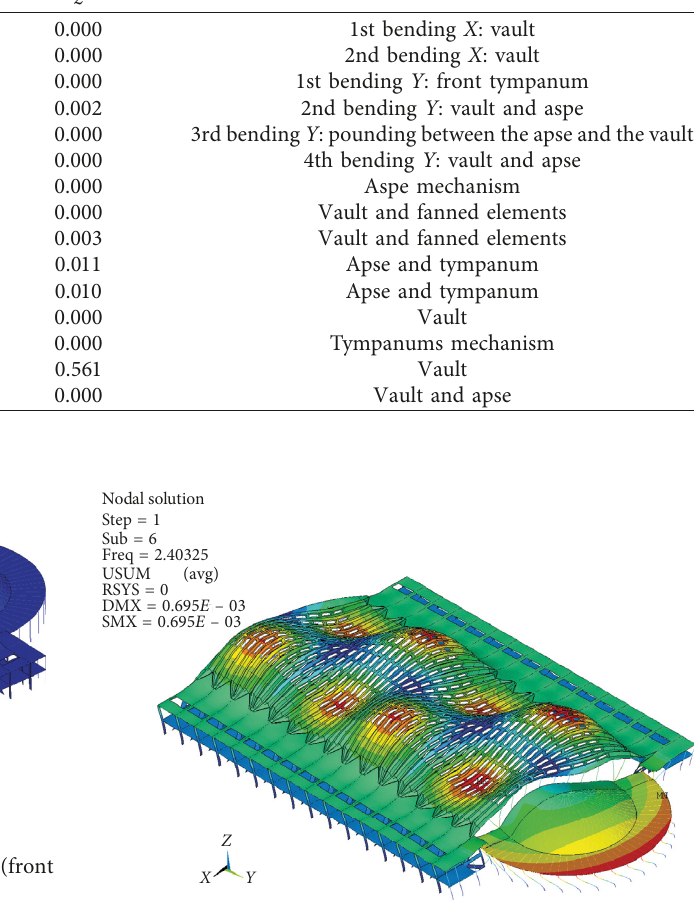
Figure 13: Mode 6 of Hall B in its damaged configuration (apse view).